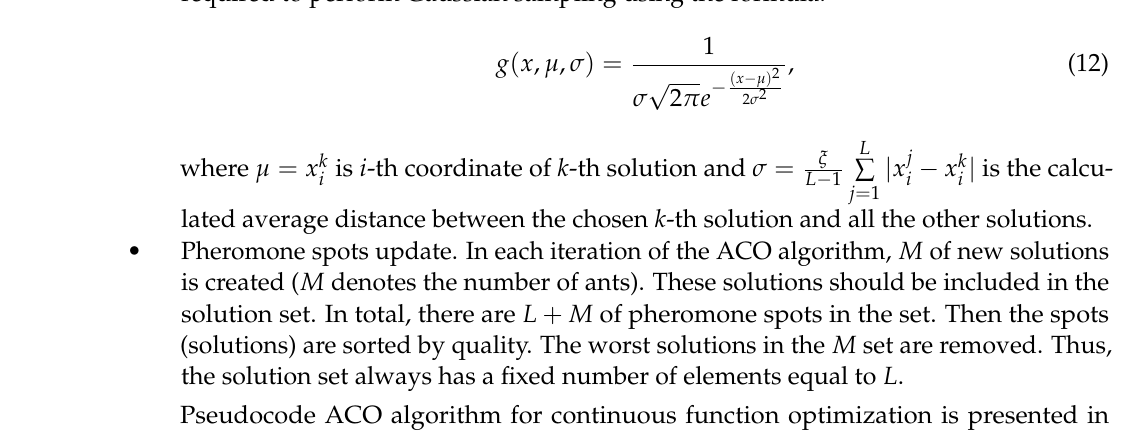
Pseudocode ACO algorithm for continuous function optimization is presented in